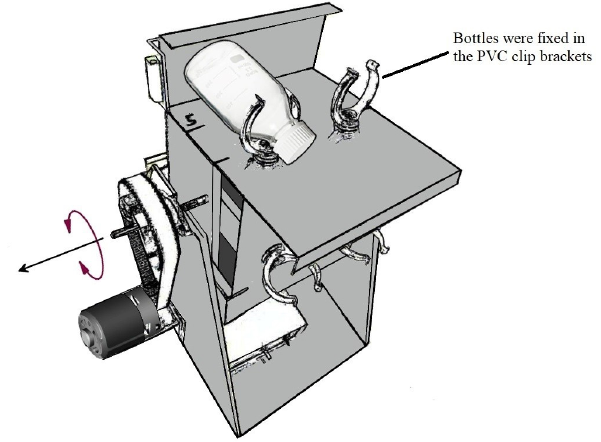
Figure 2. Sketch of the swing system. The swing systems were placed in a temperature-controlled (20 ◦ C) incubation